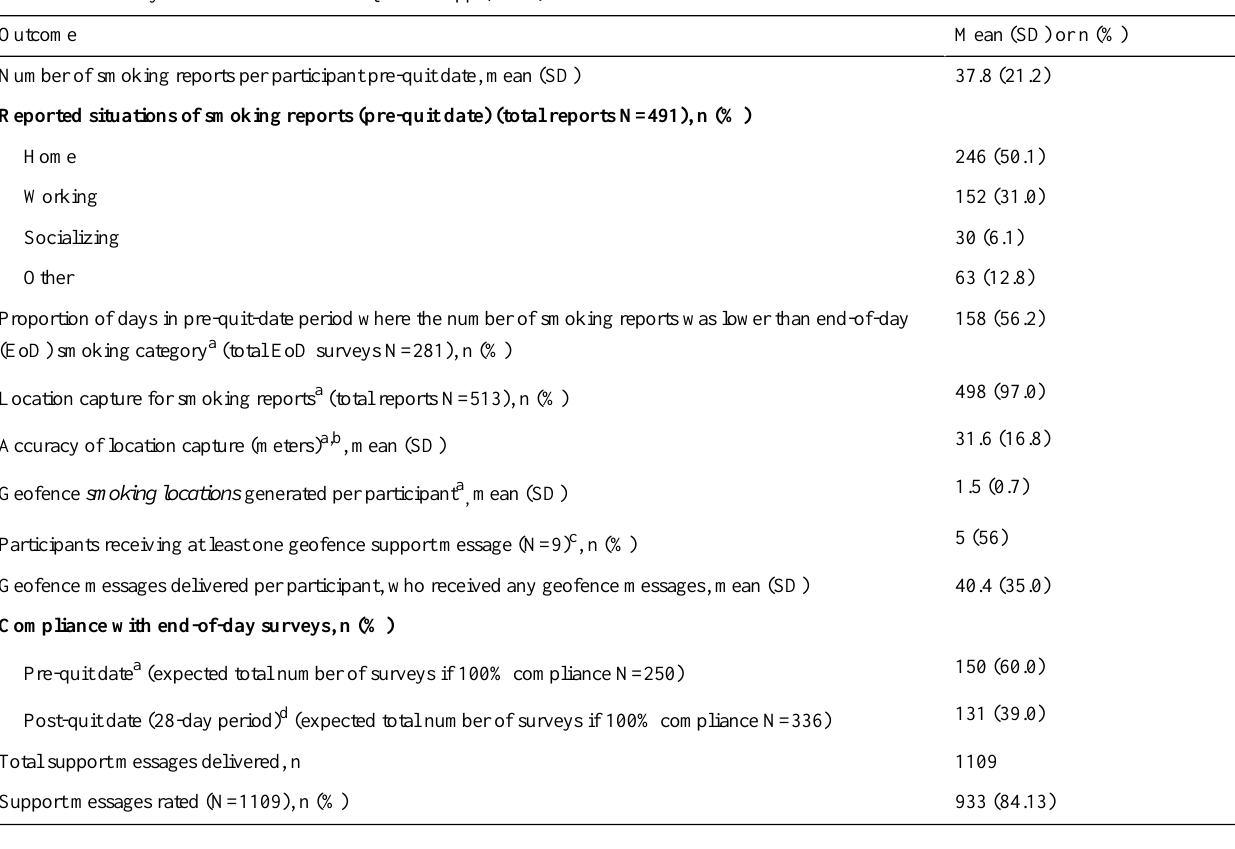
Table 2. Feasibility outcomes for use of the Q Sense app (N=15).